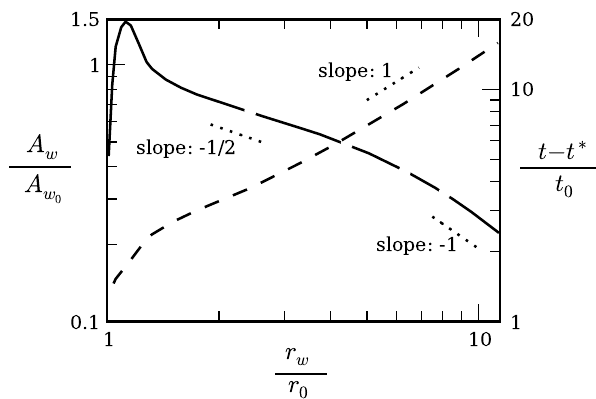
Fig. 6. The amplitude of vertical velocity, A w , versus radial position, r w , for the wave at a height of z/H = 0 . 15 (solid line). A reference amplitude, A w , is defined such that A w = 0 A w (r w /r 0 ) − 0 . 48 for 2 r 0 ≤ r w ≤ 3 r 0 . The circles correspond to 0 t/t 0 =2.5, 5.0, 7.5 and 10.0, for which wave profiles are illustrated in Fig. 7. The radial position of the wave versus time is indicated by the dashed line. A reference time, t ∗ , is defined such r w = d r w (t − t ∗ ) for 4 r 0 ≤ r w ≤ 10 r 0 . The curves are compared with d t lines of constant slope as